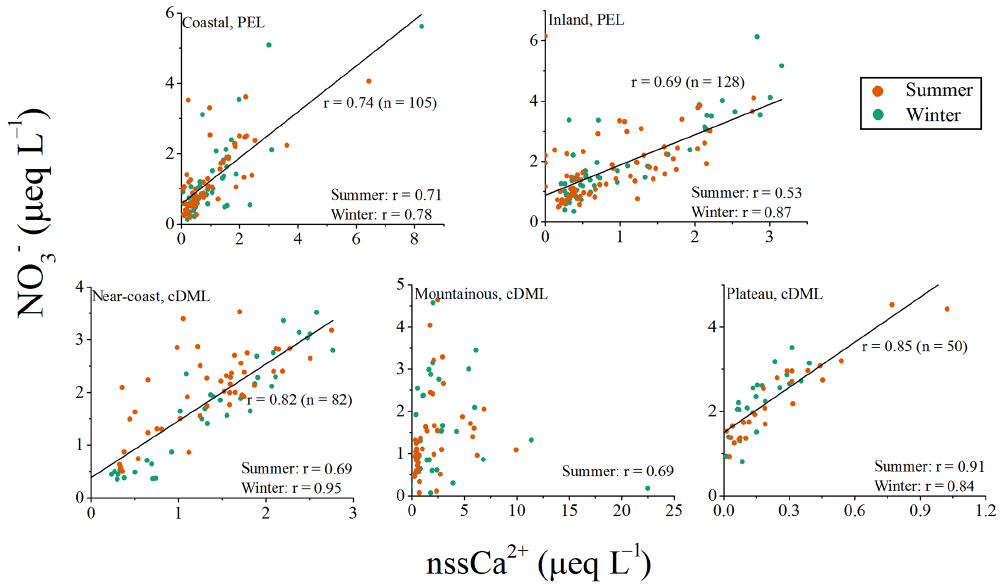
Figure 4. Correlation between nssCa 2 + and NO − during austral summer (brown) and winter (green) in the study regions in cDML and PEL. 3 Samples representing 1 complete year are plotted here to show the seasonal differences. The samples from coastal and inland sections in both cDML and PEL showed a strong association while the mountainous section in cDML transect showed weak association only during summer.